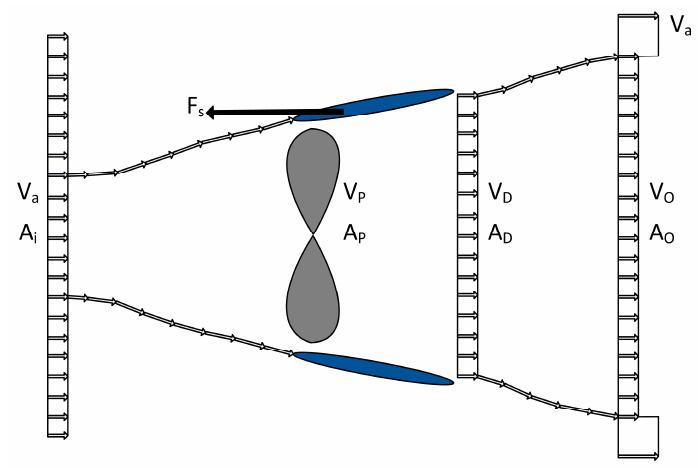
Figure 1. Model of a ducted turbine for the calculation of the extractable power from the wind.